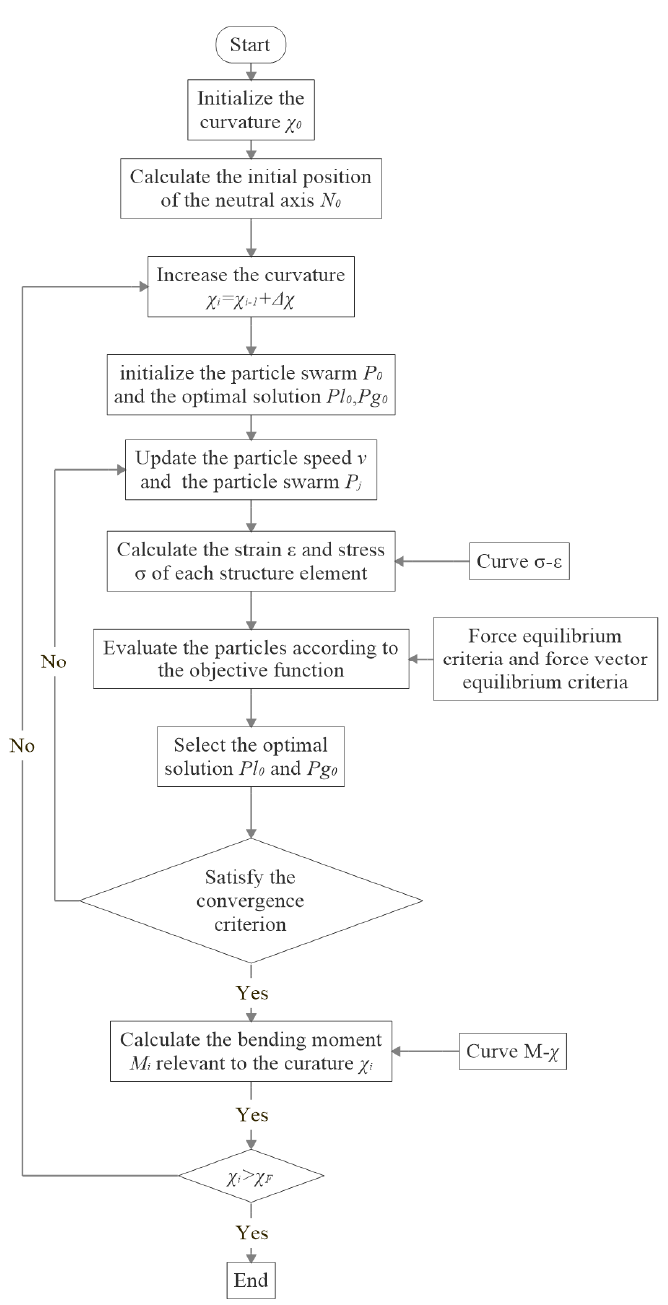
Figure 3. Flowchart of the Particle Swarm Optimisation (PSO)-based Smith Method.